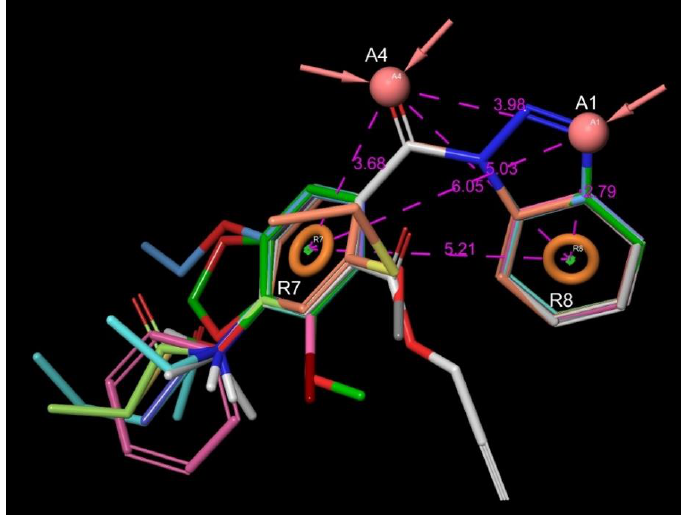
Figure 3. The selected 1,2,4-triazole model (AHRR_1). One of the aromatic groups (R7) and the acceptor group (A3) and the hydrophobic group (H6) are planar while the plane of the second aromatic group (R9) is twisted.